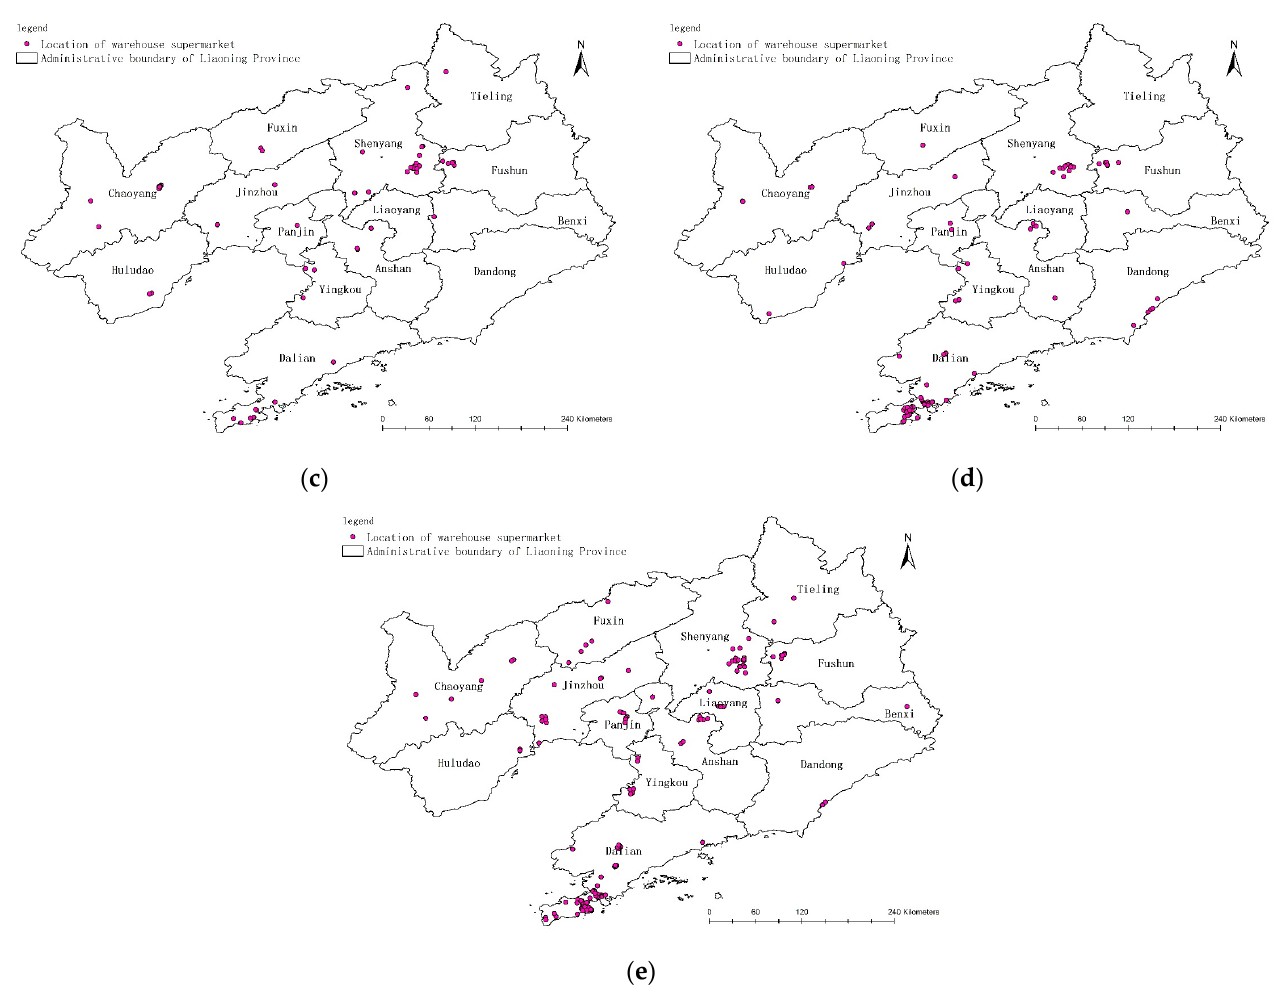
Figure 3. Dynamic changes in the number of warehousing supermarkets in Liaoning Province from 2018 to 2022. ( a ) Data for 2018; ( b ) data for 2019; ( c ) data for 2020; ( d ) data for 2021; ( e ) data for 2022.